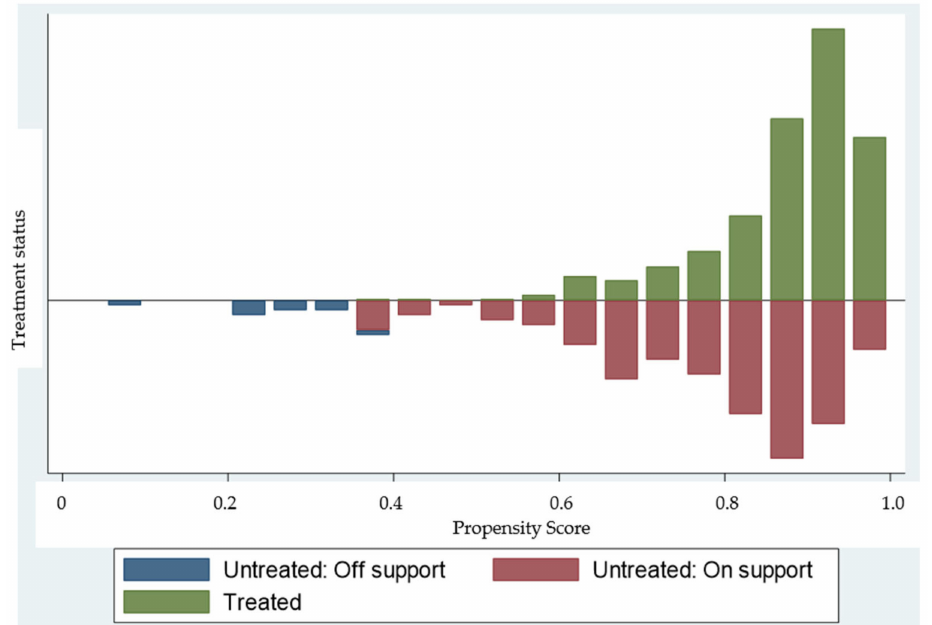
Figure 1. Distributions of the estimated propensity scores between treated and control groups. To check the quality of matching, we conducted a balancing test for exogenous vari- ables before and after matching. We examined the reduction rate of bias using standardized bias and then compared the average bias before and after matching between groups. If con- ditional independence assumption holds, small values of standardized bias indicates a